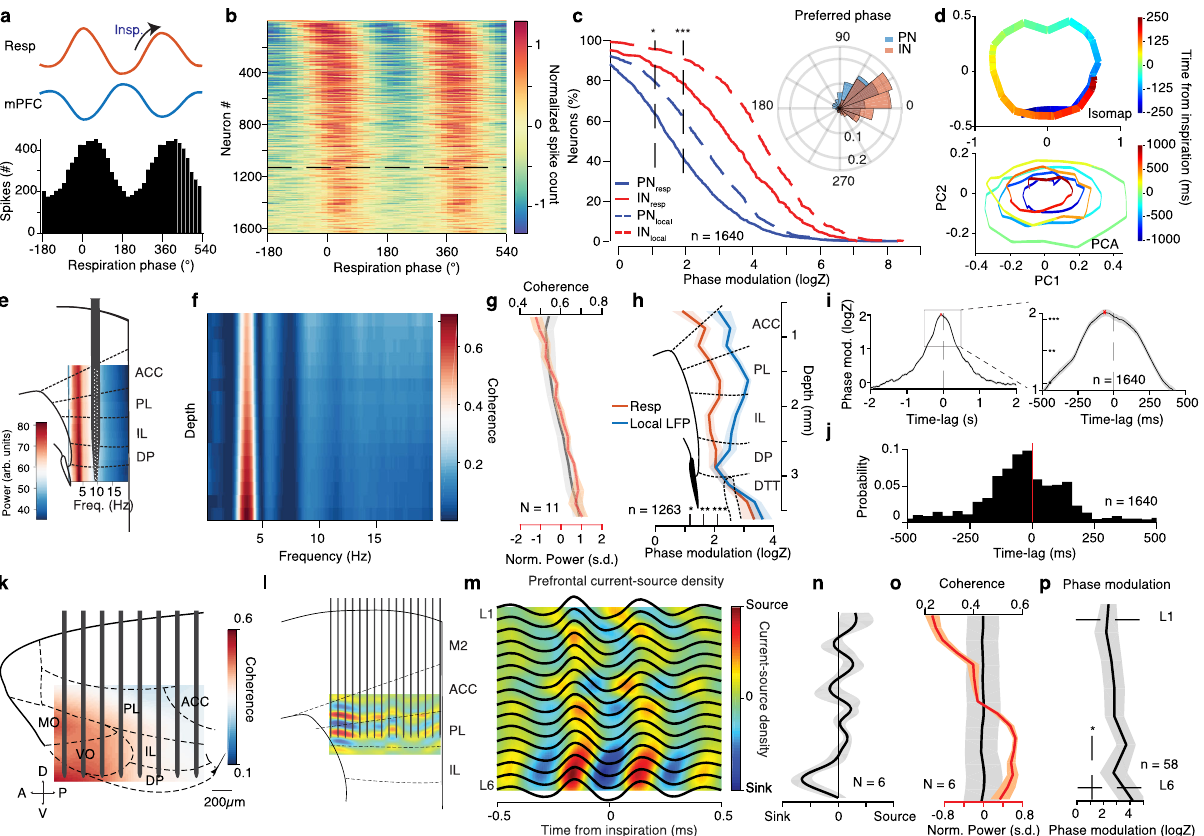
Fig. 2 Topography of prefrontal circuit entrainment by breathing. a Example respiration phase histogram. Top, average respiration (red) and mPFC LFP (blue) traces. b Color-coded phase histograms of all prefrontal neurons ( n = 1640 neurons, N = 13 mice). Horizontal line: signi fi cance threshold. c Cumulative distribution of the logZ for all prefrontal PNs (blue, n = 1250 neurons) and INs (red, n = 390 neurons) in relation to respiration (solid lines) and local LFP (vertical dashed lines). Inset: Distribution of the preferred phase for PNs (blue) and INs (red). d Example Isomap (top) and PCA (bottom) trajectories of the mPFC population activity triggered on inspiration. e Schematic of a silicon polytrode in the deep layers of the mPFC, overlaid on an example depth- and frequency-resolved power spectrum spanning all mPFC subregions. f Example depth- and frequency-resolved coherence between respiration and local prefrontal LFP. g Average depth-resolved power (red) and coherence in the 2 – 5 Hz band (black) ( N = 11 mice). h Depth-resolved spike phase modulation statistics (logZ) (as in ( c )) ( n = 1263 cells, N = 11 mice). i Time-lagged phase modulation of prefrontal population, indicative of directionality from respiration to prefrontal activity. Peak lag is − 65ms. j Time-lag distribution for the prefrontal population ( n = 1640 neurons, N = 13 mice). k Example 2D coherence throughout the frontal subregions. l Schematic of a translaminar recording from the mPFC using a 16-shank probe (50 μ m spacing) and example inspiration-triggered CSD pro fi le. m Example average inspiration-triggered LFP traces and overlaid corresponding translaminar CSD from the mPFC. n Average inspiration-triggered translaminar normalized CSD from the mPFC ( N = 6). o Average laminar pro fi le of the 2 – 5 Hz band LFP power (red) and coherence with respiration (coherence) ( N = 6). p Laminar unit phase modulation statistics (logZ) ( n = 58 cells, N = 6). Shaded